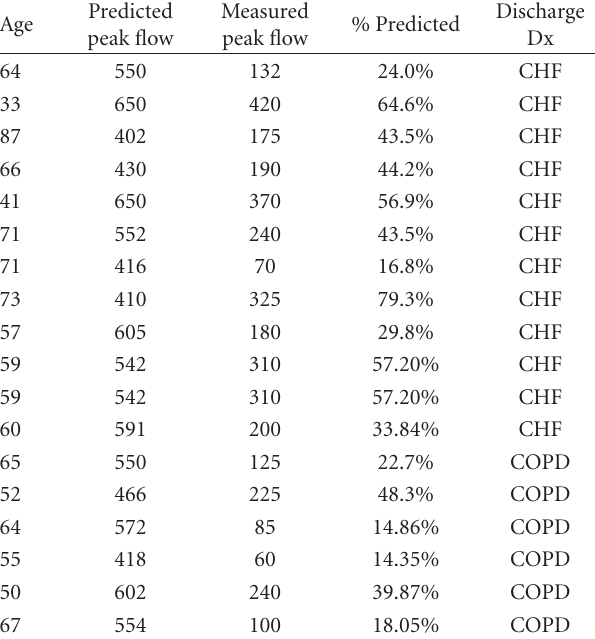
Table 1: Patients enrolled in